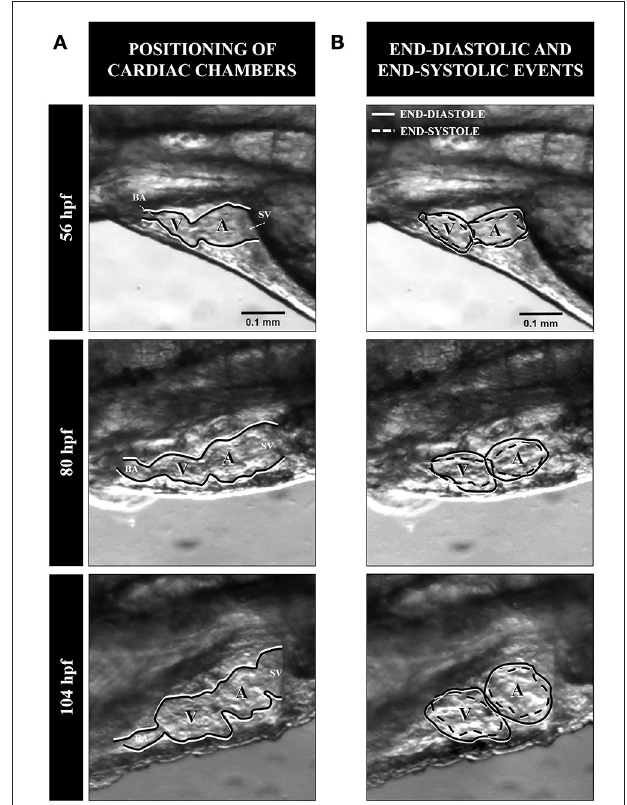
FIGURE 1 | Shape and rhythmic changes of the heart of larval mahi during the early post-embryonic stages of 56, 80, and 104 h post-fertilization. (A) Morphology and general outline of cardiac chambers in left lateral view. (B) Heart chambers are outlined during end-diastole (solid line) and end-systole (dashed line). Note the relative changes in volume of the atrium and ventricle as development progresses. BA, Bulbous arteriosus; A, atrium; V, ventricle; SV, sinus